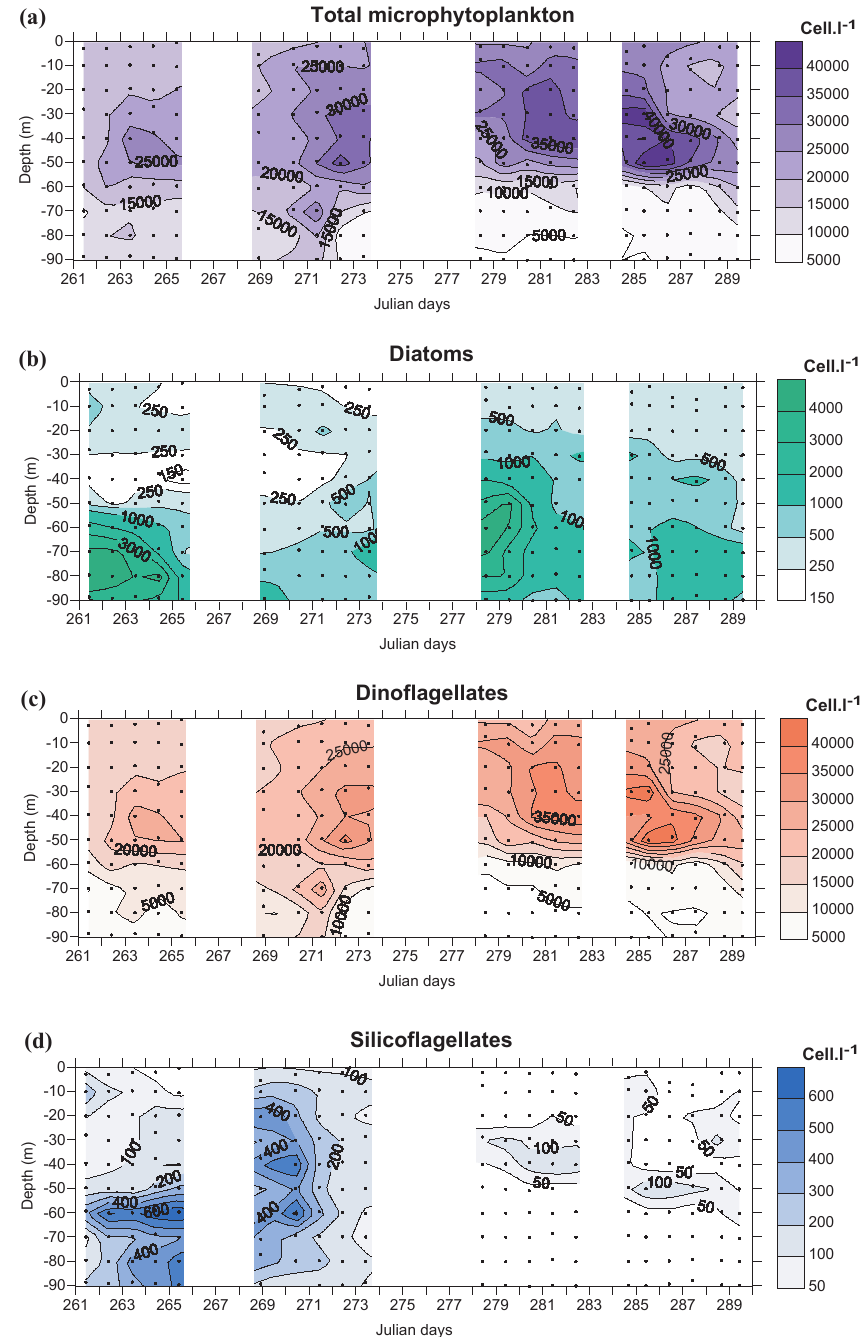
Fig. 2. Abundance of microphytoplankton during DYNAPROC 2 cruise, from hydrological bottle sampling (a) Total microphytoplankton, (b) Bacillariophyceae, (c) Dinophyceae, (d) Dictyochophyceae.